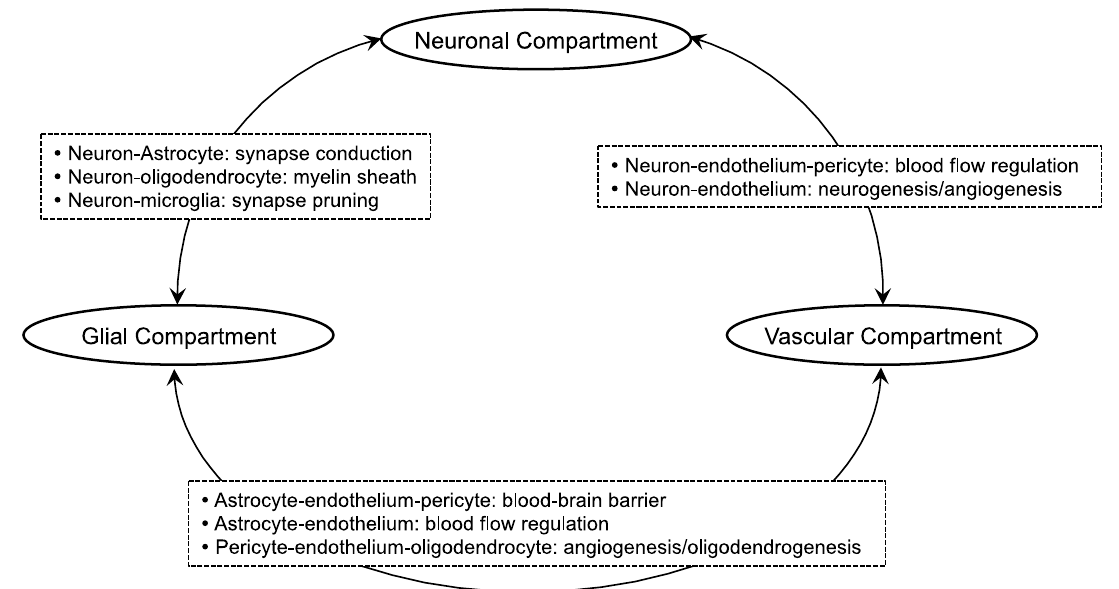
Figure 1. Schematic of the neurovascular unit (NVU): One of the key messages from the concept of the neurovascular unit may be that cell-cell interaction is critical for maintaining brain function. This schematic introduces some examples of how each component works together in the neurovascular unit. The neuronal compartment may include neuronal precursor cells along with neurons. The glial compartment includes astrocytes, oligodendrocytes, and microglia. The vascular compartment may include both endothelium and pericytes. Please note that there are several important mechanisms of cell-cell interaction even within each compartment. For example, in the glial compartment, microglia regulate the phenotypic change in astrocytes [7] . Also in the same compartment, oligodendrocytes interact with astrocytes and microglia.